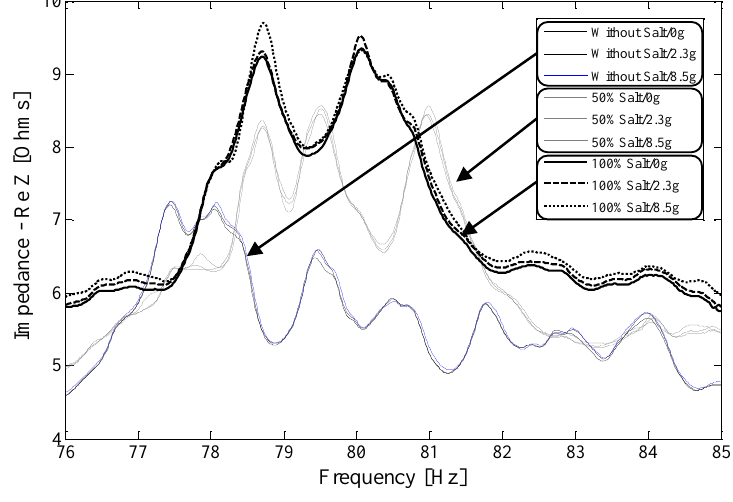
Fig. 9. Impedance measurements – Ionic